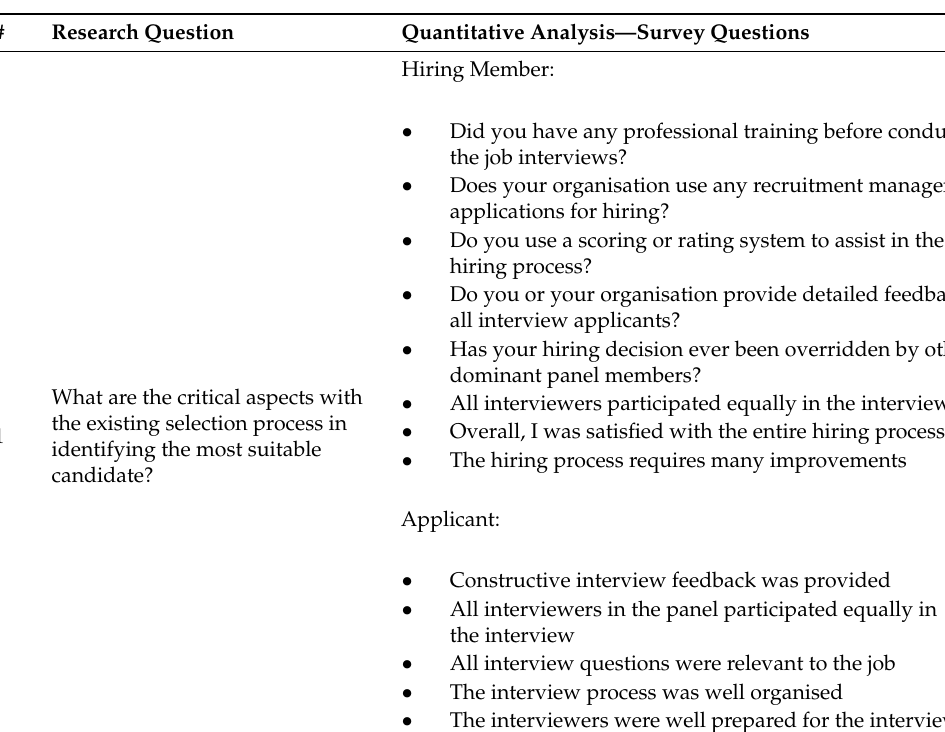
Table 1. Research Question Mapped with Survey Questions.